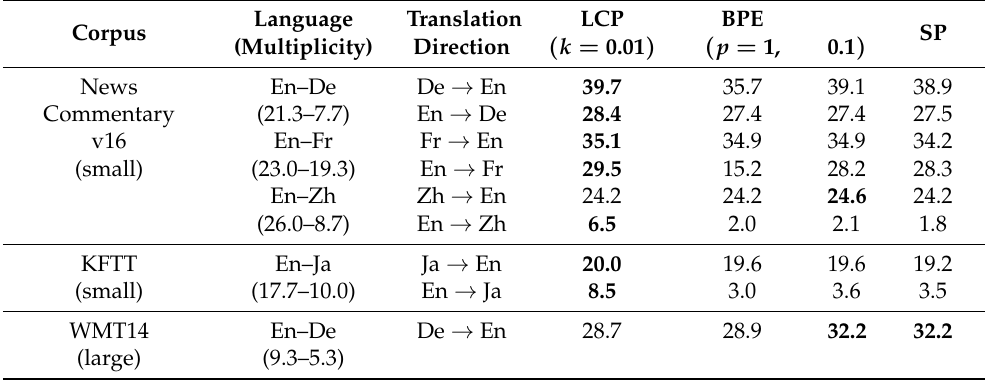
Table 5. Experimental results of LCP-dropout (denoted by LCP), BPE-dropout (denoted by BPE), and SentencePiece (denoted by SP) on various languages in Table 2 (small corpus: News Commentary v16 and KFTT, and large corpus: WMT14), where ‘multiplicity’ denotes the average number of sequences generated per input string. Bold indicates the best